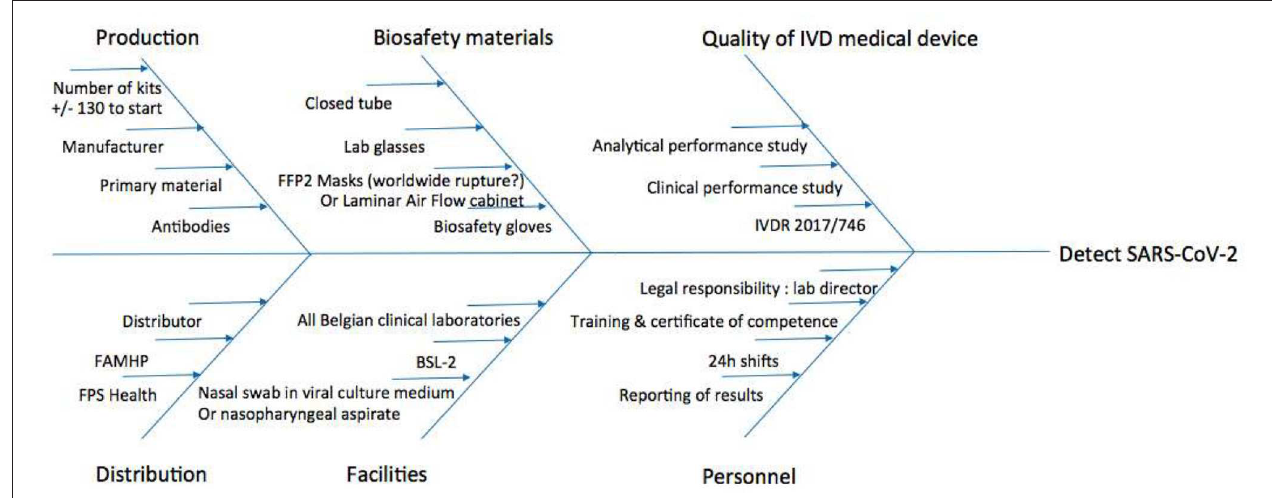
FIGURE 3 | Ishikawa diagram of rapid SARS-CoV-2 diagnostic tests for Clinical Labs’ implementation. BSL-2, Biosafety Level 2; FAMHP, Belgian Federal Agency for Medicines and Health Products; FFP2, Filtering Facepiece Respirator Class 2; FPS Health, Belgian Federal Public Service Health, Food Chain Safety and Environment; IVDR, European Regulation 2017/746 on in vitro Diagnostic Medical